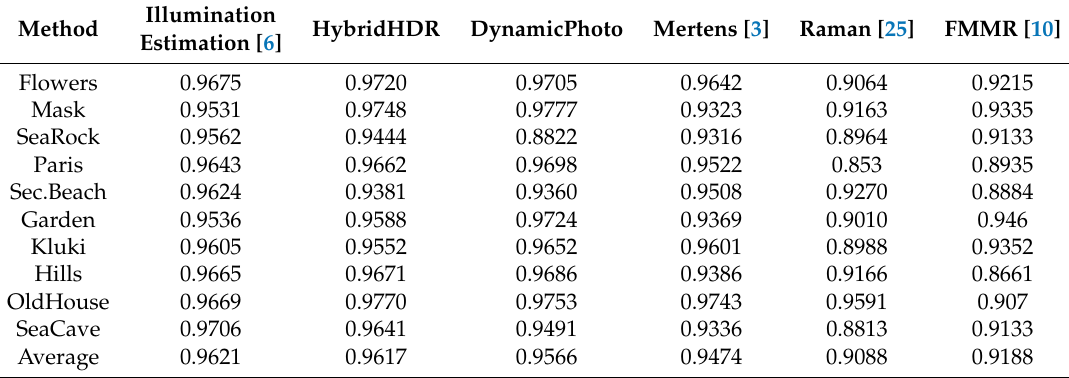
Figure 2. Ten images from various MEF databases and a developed dataset. These ten images were used in our experiments. This figure depicts the results of our method. Table 1. Objective Quality evaluation for the six multiple-exposure fusion algorithms using the Ma et al. [26]